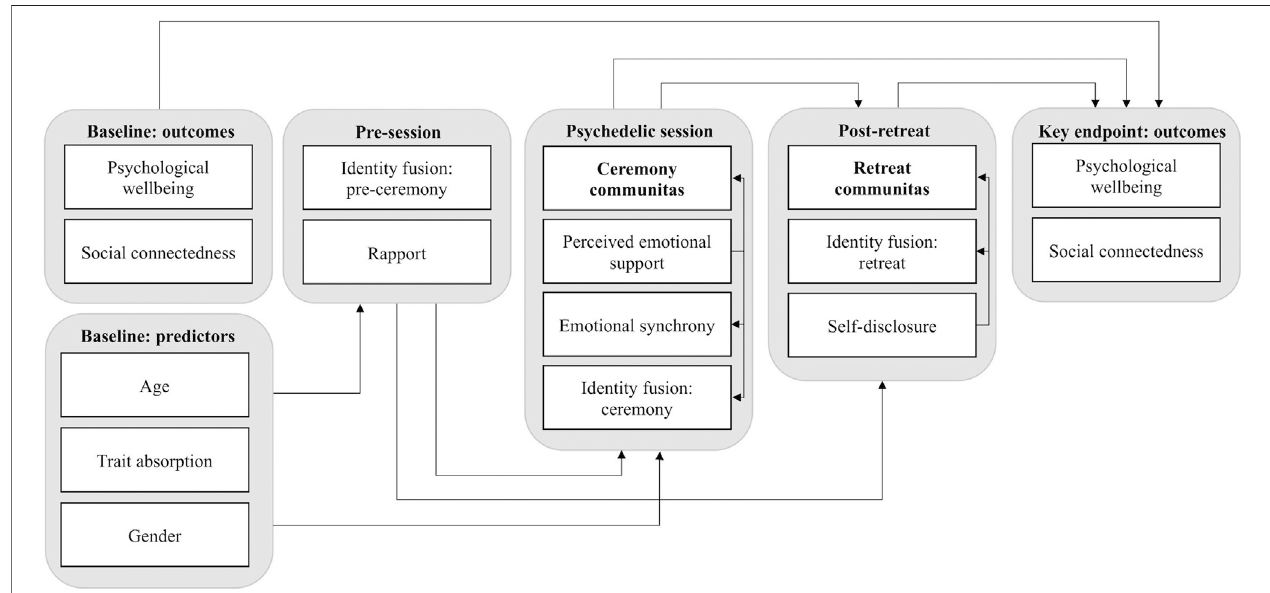
FIGURE 1 | Initial path model showing hypothesized relationships of psychosocial variables during settings of collective psychedelic use, measured across 5 time points.